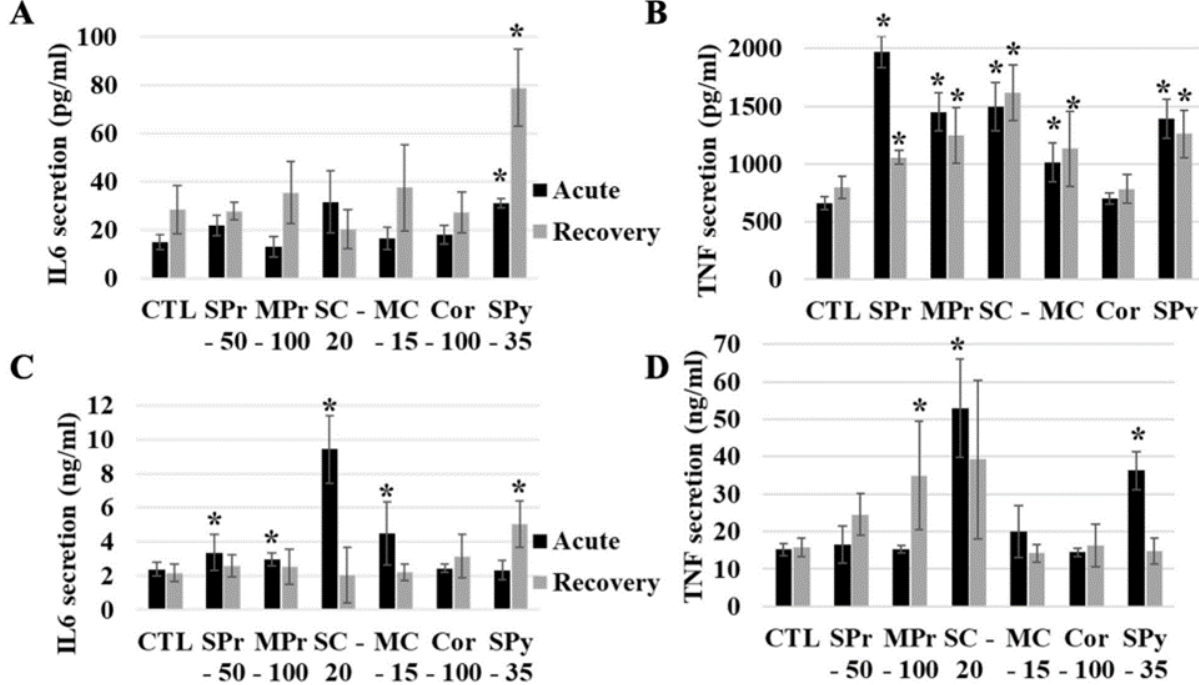
Figure 4. Cytokine responses of cells exposed to SiO 2 particles and stimulated (or not) with lipopol- ysaccharide. The acute exposure is (or is not) followed by a 72-h recovery period. CTL: control cells, SPr: small-particle precipitated silica 220 m 2 /g, MPr: medium-particle precipitated silica 55 m 2 /g, SC: colloidal 220 m 2 /g, MC: colloidal 140 m 2 /g, Cor: corundum, SPy: small-particle pyrogenic silica 200 m 2 /g. Black bars for acutely exposed cells, grey bars for recovery protocol. The data are expressed as mean ± standard deviation. IL-6: interleukin 6; TNF: tumor necrosis factor alpha. ( A ) Intrinsic IL- 6 secretion of cells exposed to SiO 2 . ( B ) Intrinsic TNF secretion. ( C ) IL-6 secretion after LPS stimula- tion. ( D ) TNF secretion after LPS stimulation. Statistical significance in a Mann-Whitney test: * p < 0.05